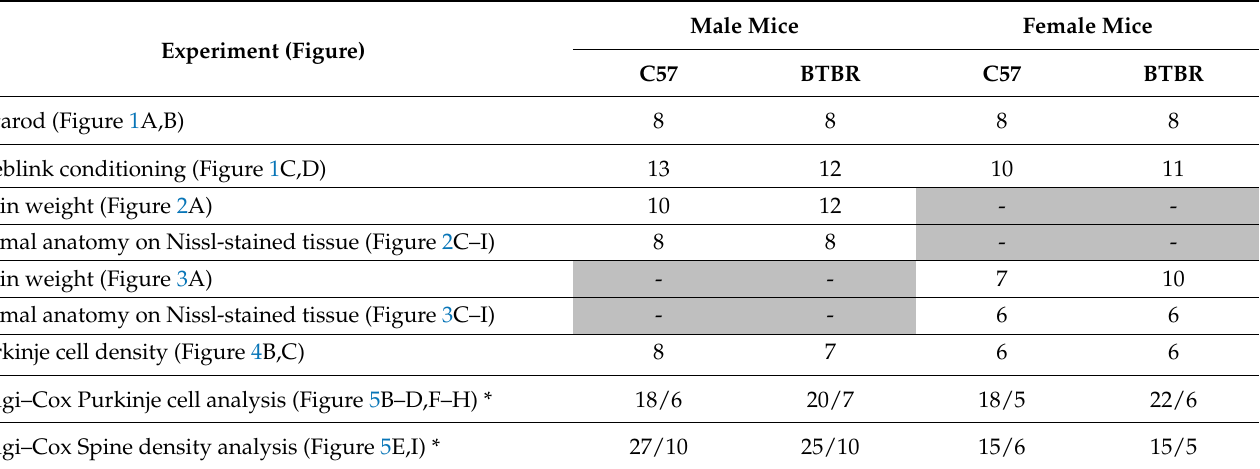
Table 1. Sample size for all experiments, listed by sex, strain, experiment, and figure number. Shaded cells are indicated for figures that only report data from a single sex. *, sample size reported as number of cells/number of